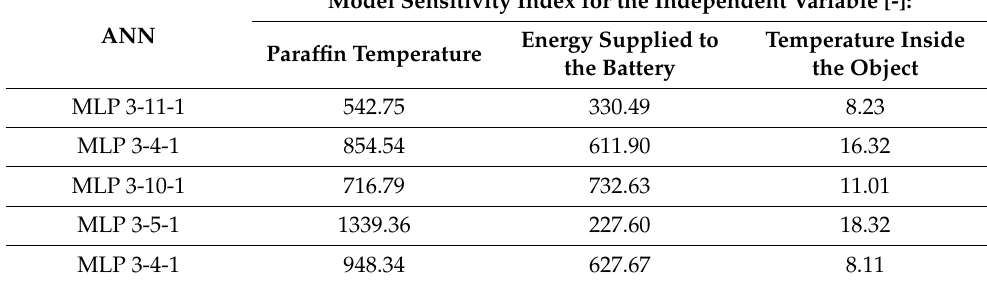
Table 5. Independent variable sensitivity analysis for the PCM battery energy storage model. Model Sensitivity Index for the Independent Variable [-]: ANN Energy Supplied to Temperature Inside Paraffin Temperature the Battery the Object